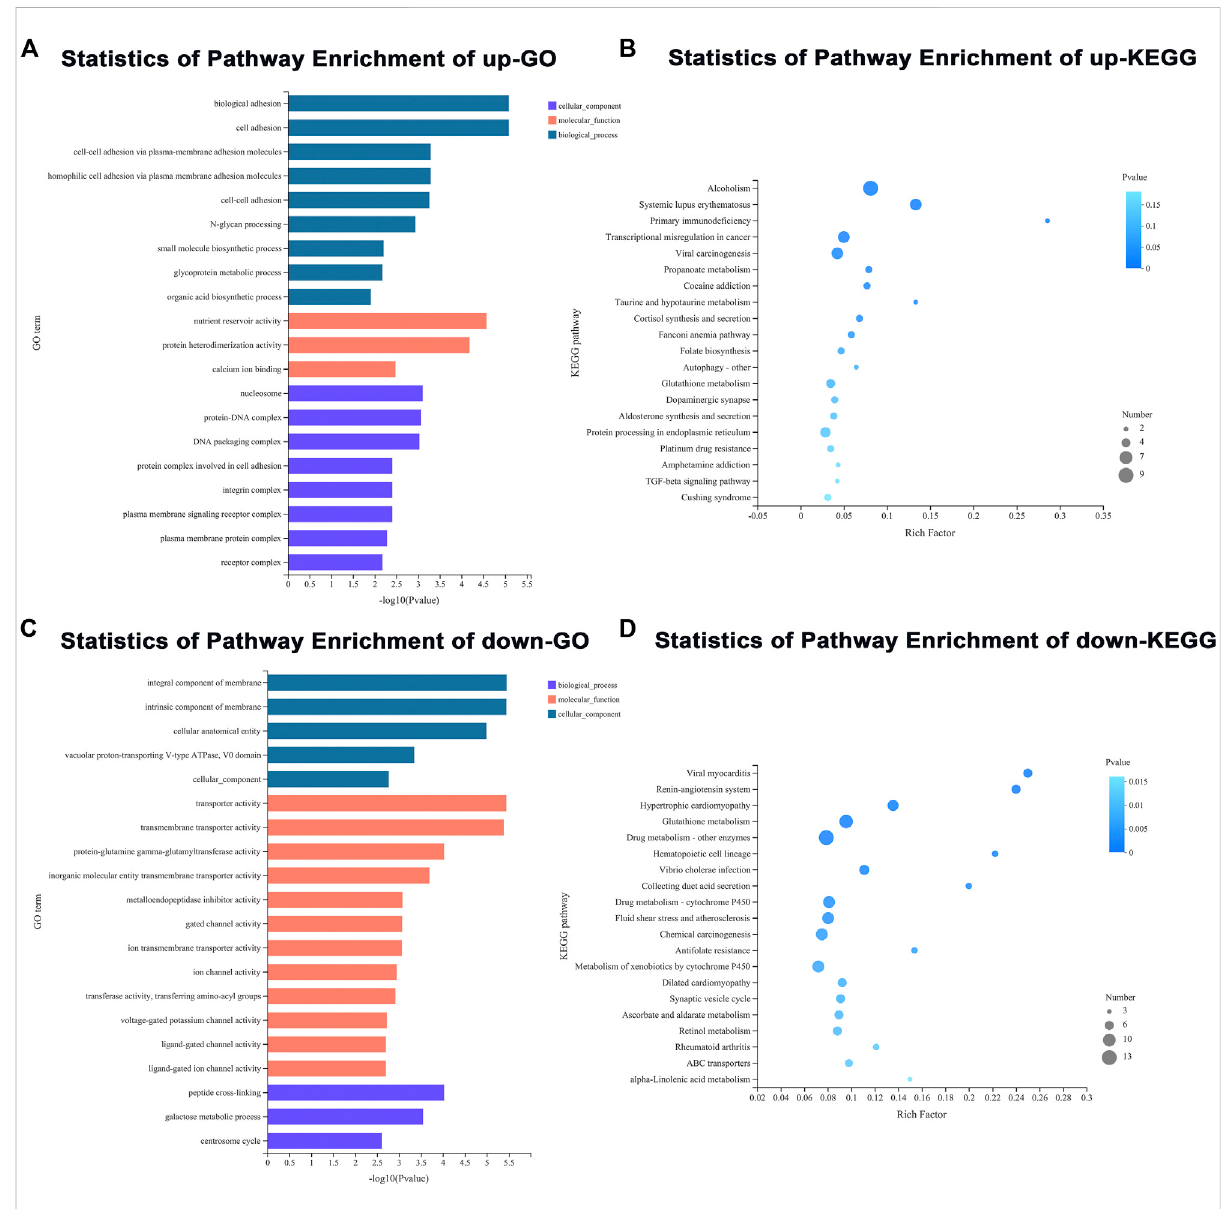
FIGURE 4 GO and KEGG enrichment analyses. (A,B) GO and KEGG pathway enrichment analyses of downregulated DEGs. (C,D) GO and KEGG pathway enrichment analyses of upregulated